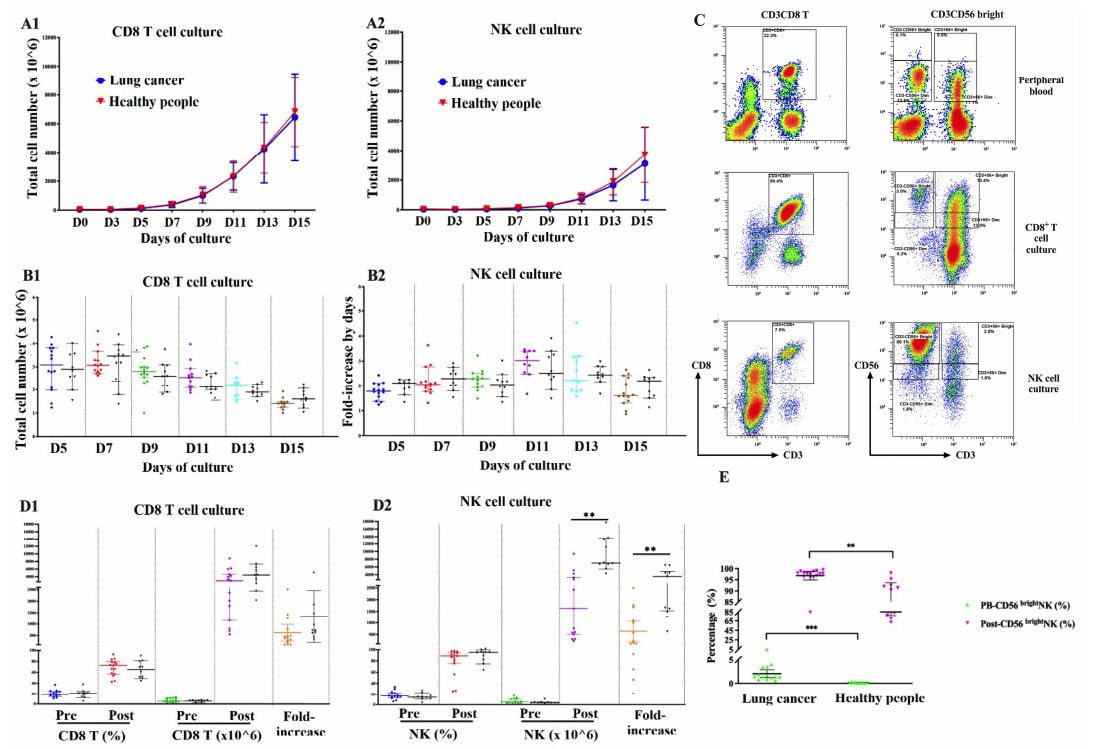
Figure 2. The proliferation of immune cells during 15 days of culture in lung cancer patients and healthy people. The growth curves of total cells in CD8 + T cell ( A1 ) and NK cell cultures ( A2 ). The fold increase of total cells every two days from D3 to D15 in CD8 + T cell culture ( B1 ) and NK cell cultures ( B2 ). The gating strategy to identify and count T cell and NK cell subsets by flow cytometry ( C ). The expansion of NK cells ( D1 ) and CD8 + T cells ( D2 ) after 15 days of culture. The changes in the frequency of CD56 bright NK cells in PB and after 15 days of culture ( E ). Pre: at cell seeding; Post: at cell harvesting after culture. Significance levels were set to p < 0.01 (**), and p < 0.001 (***).